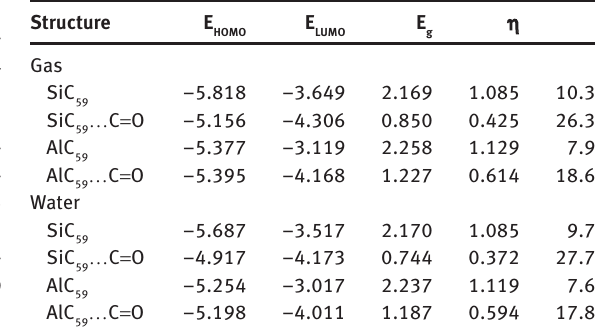
Table 3: Electronic parameters (eV) of the structures.